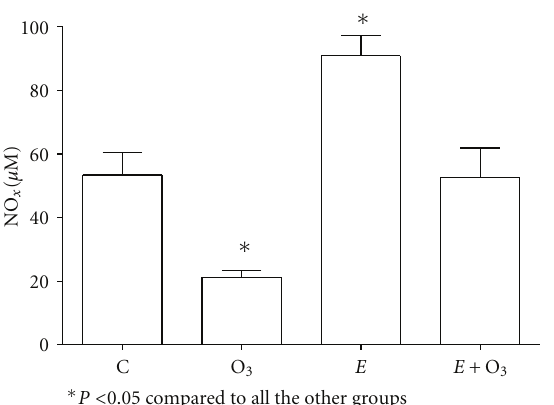
Figure 4: Plasma malondialdehyde (MDA) concentrations at week 2. Ozone (O 3 , 0.5 ppm 4 hours/day) exposure significantly increased MDA levels. Even though exercise (90 min per day) did not change MDA, it blocked completely O 3 e ff ect. Data were analyzed using the one-way ANOVA test and Tukey’s multiple comparison test post hoc . Data are shown as the mean ± standard error of mean ( n = 6 per